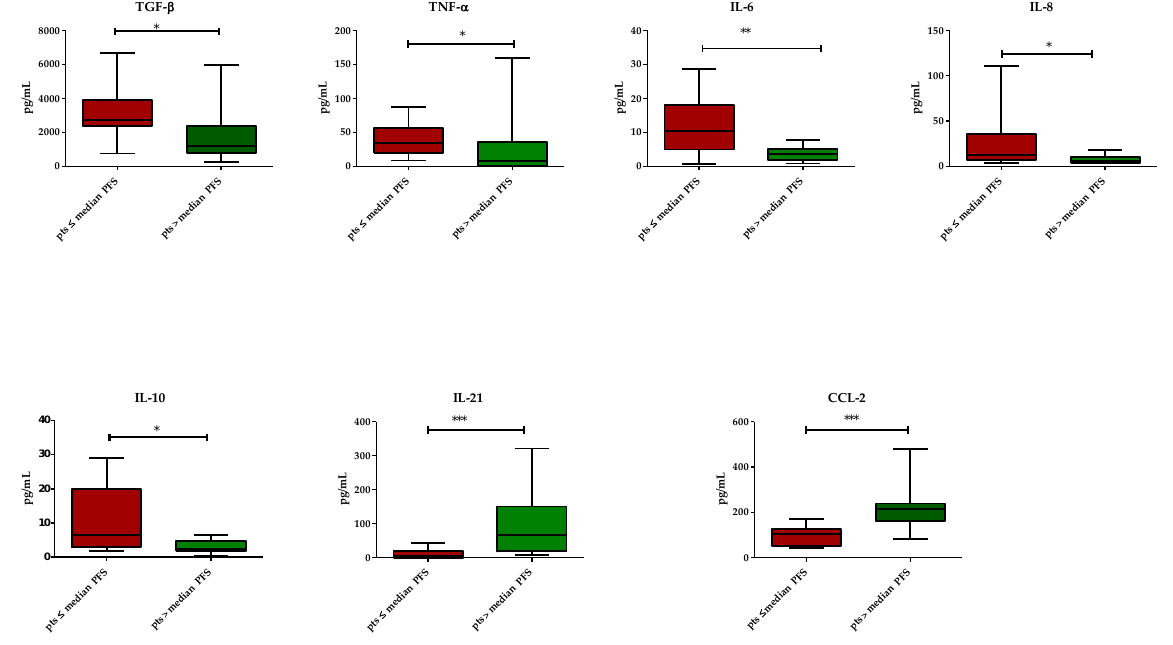
Figure 1. Distributions of cytokines: red bars represent patients with PFS ≤ 2.9 months and green bars represent patients with PFS > 2.9 months. Only cytokines with any statistical significance were shown. Data are expressed as medians with ranges. *** p < 0.001, ** p < 0.01, * p < 0.05. CCL, C-C motif ligand; IL, interleukin.